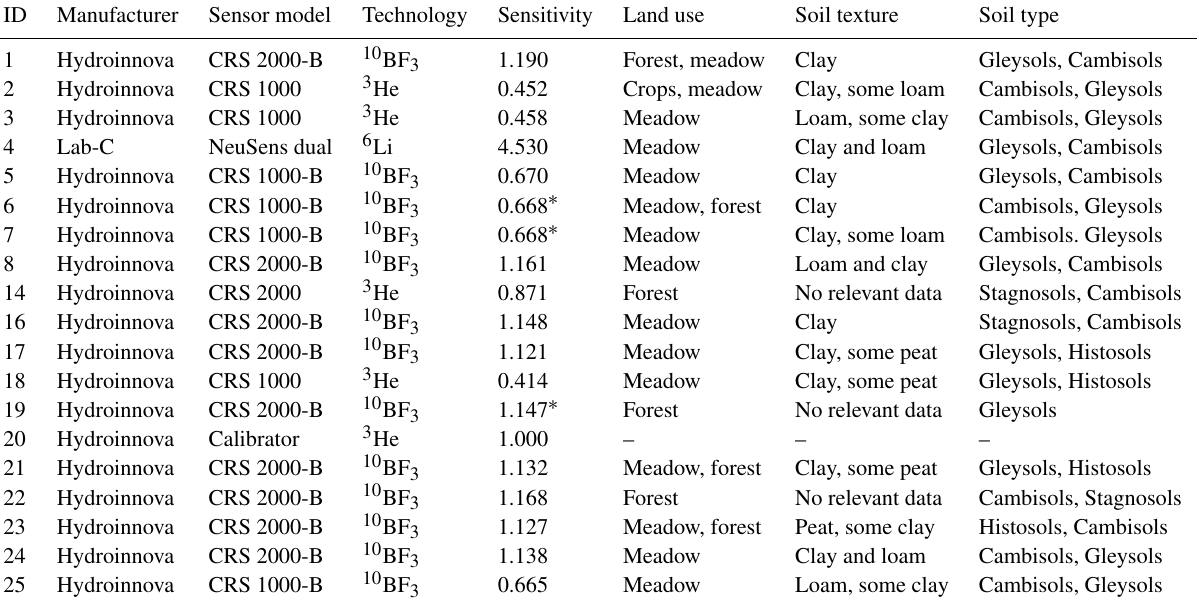
Table 1. Overview of the 18 CRNS sensors used in this study, including manufacturer, sensor model, detection technology, sensitivity of the sensor relative to the calibrator probe (#20), dominant land use (from OpenStreetMap contributors, 2020), soil texture class (from Landesamt für Digitalisierung, Breitband und Vermessung, 2018, not available under forest cover) and soil type (from Bayerisches Landesamt für Umwelt, 2014) in the sensor footprint. Please note that the sensor IDs in this table are non-consecutively numbered to maintain consistency with Fersch et al.